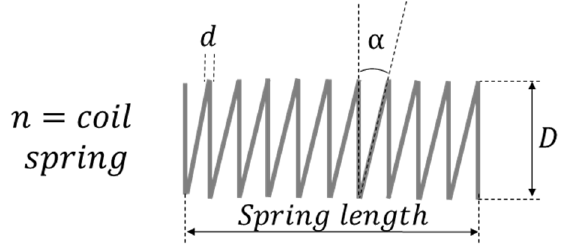
Figure 1. Geometric parameters of the tested springs.